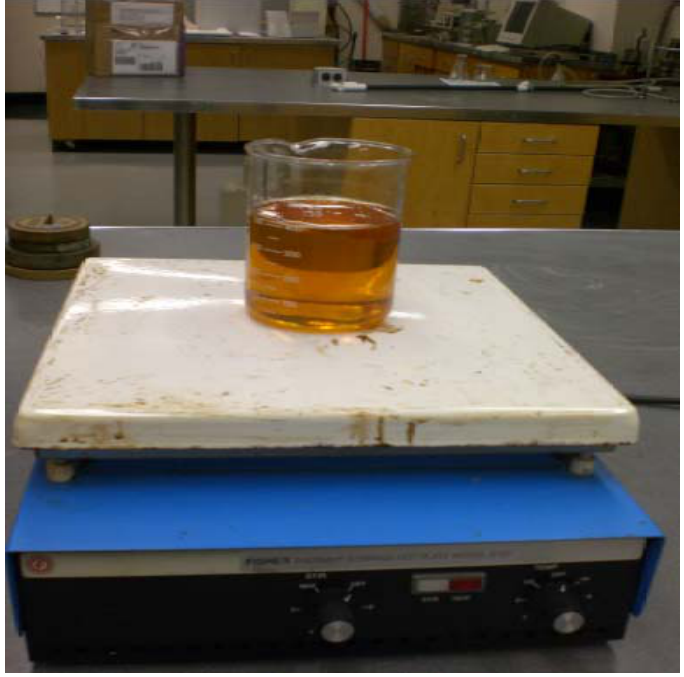
Figure 5. Glass reactor with heating plate and magnetic stirrer.